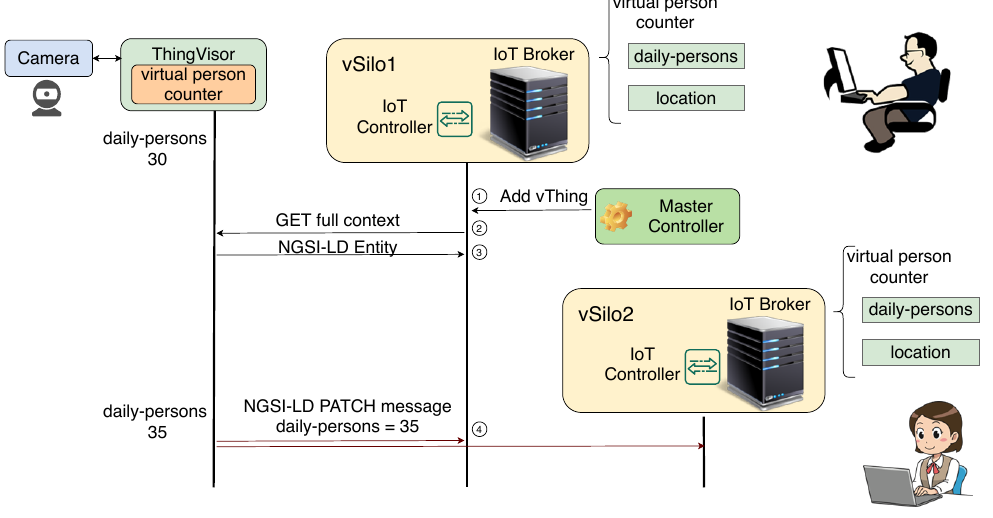
Figure 7. Virtual Sensor